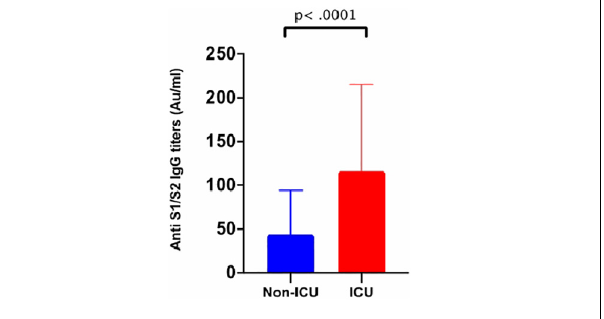
FIGURE 3 | Anti S1/S2 IgG titers stratified by ICU admission. Bar chart showing that participants who required ICU admission generated significantly higher Anti S1/S2 IgG titers compared to those who did not ( p <